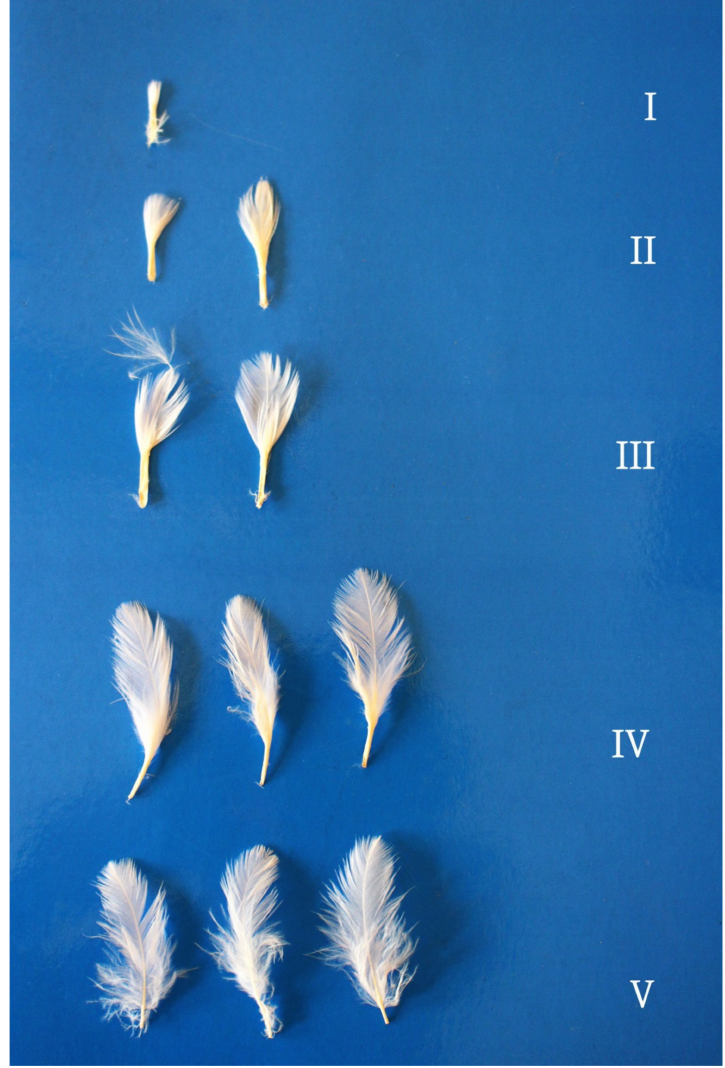
Figure 2. Interscapular feathers in a 4-week-old turkey. Feather growth stages: I—pinfeather covered in sheath; II– barbs protruding from the sheath; III—plumulaceous (loose) vane (thigh), pennaceous (coherent) vane (interscapular region), feathers unsheathed by 1 / 2 of rachis length; IV—plumulaceous (loose) vane (thigh), pennaceous (coherent) vane (interscapular region), feathers unsheathed by 3 / 4 of rachis length; V—mature feathers, feather length: shortest—2.5 cm, longest—3.0 cm, absence of afterfeathers and empty spaces between